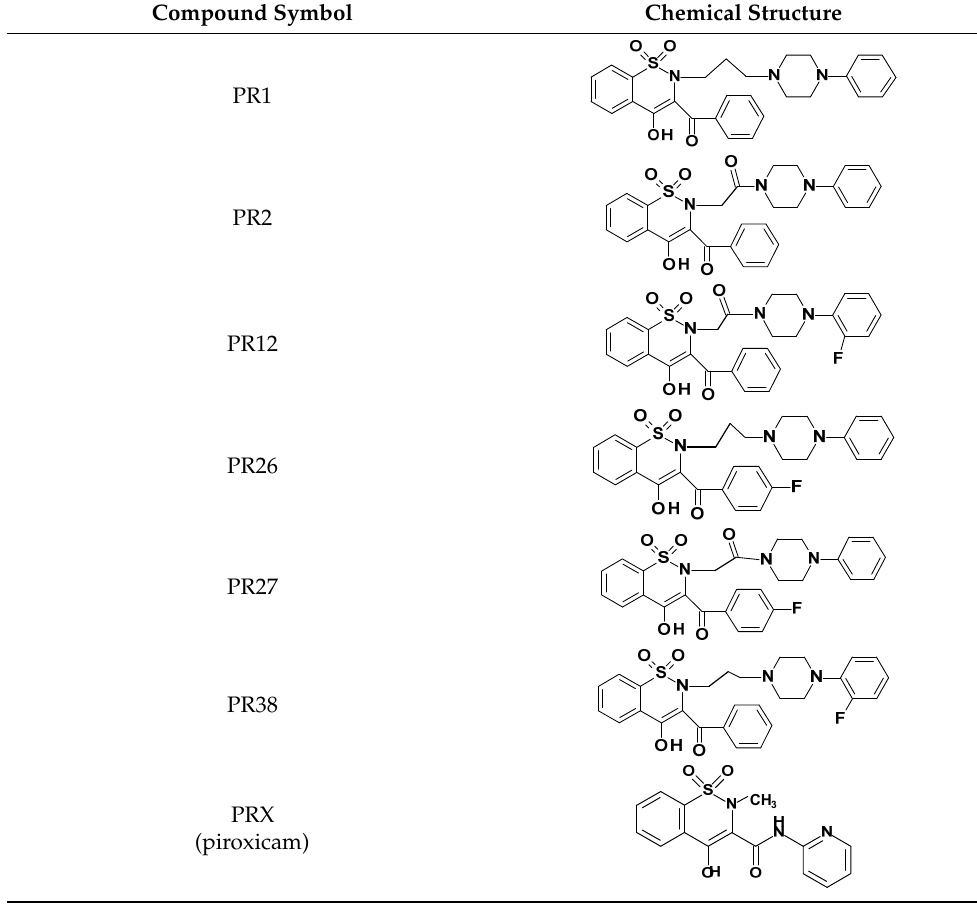
Table 1. Chemical structures and symbols of studied compounds.